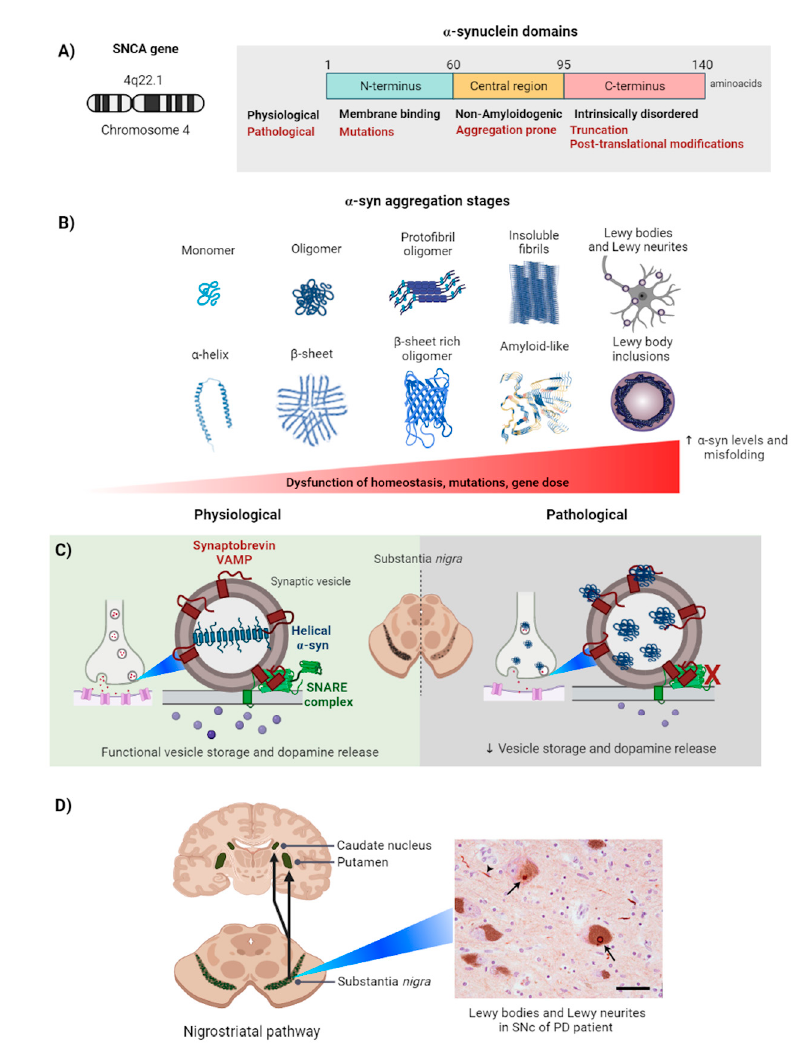
Figure 1. Misfolding and aggregation of α -syn in PD. ( A ) Left: SNCA gene coding for the α -syn on chromosome 4. Right: Structure of α -syn (Protein Data Base, PDB, 1XQ8) highlighting its different domains and its involvement in cell physiology (black) as well as in various alterations that come to affect its function (red) [17]. ( B ) Aggregation states of α -syn: structure (above) and three-dimensional composition (PDB 6OSJ) (below) by crystallography. ( C ) α -syn activity under physiological conditions (left), as well as in alterations to its function (right). Image modified from Burré et al. (2010) [18]. ( D ) Left: Nigrostriatal pathway, which originates in the SNpc and projects to the dorsal striatum. Right: α -syn inclusions in the form of LBs (arrows) and neurites (arrowheads) from a PD patient (20×). Scale = 50 μ m. Image taken from Ingelsson (2016) [19].